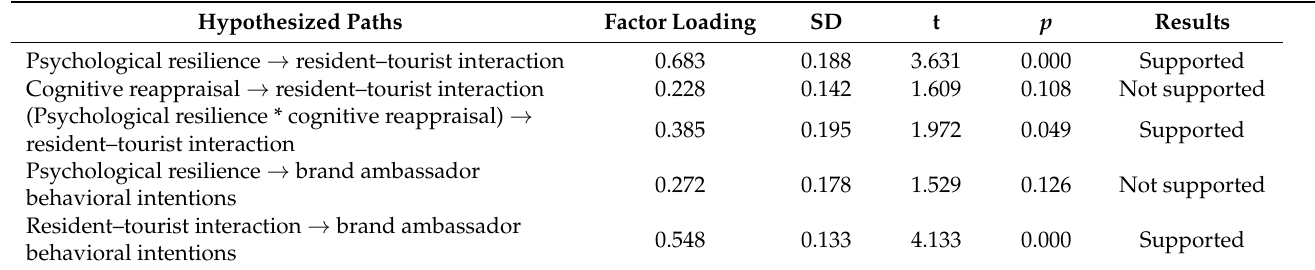
Table 5. Direct and indirect effects (model